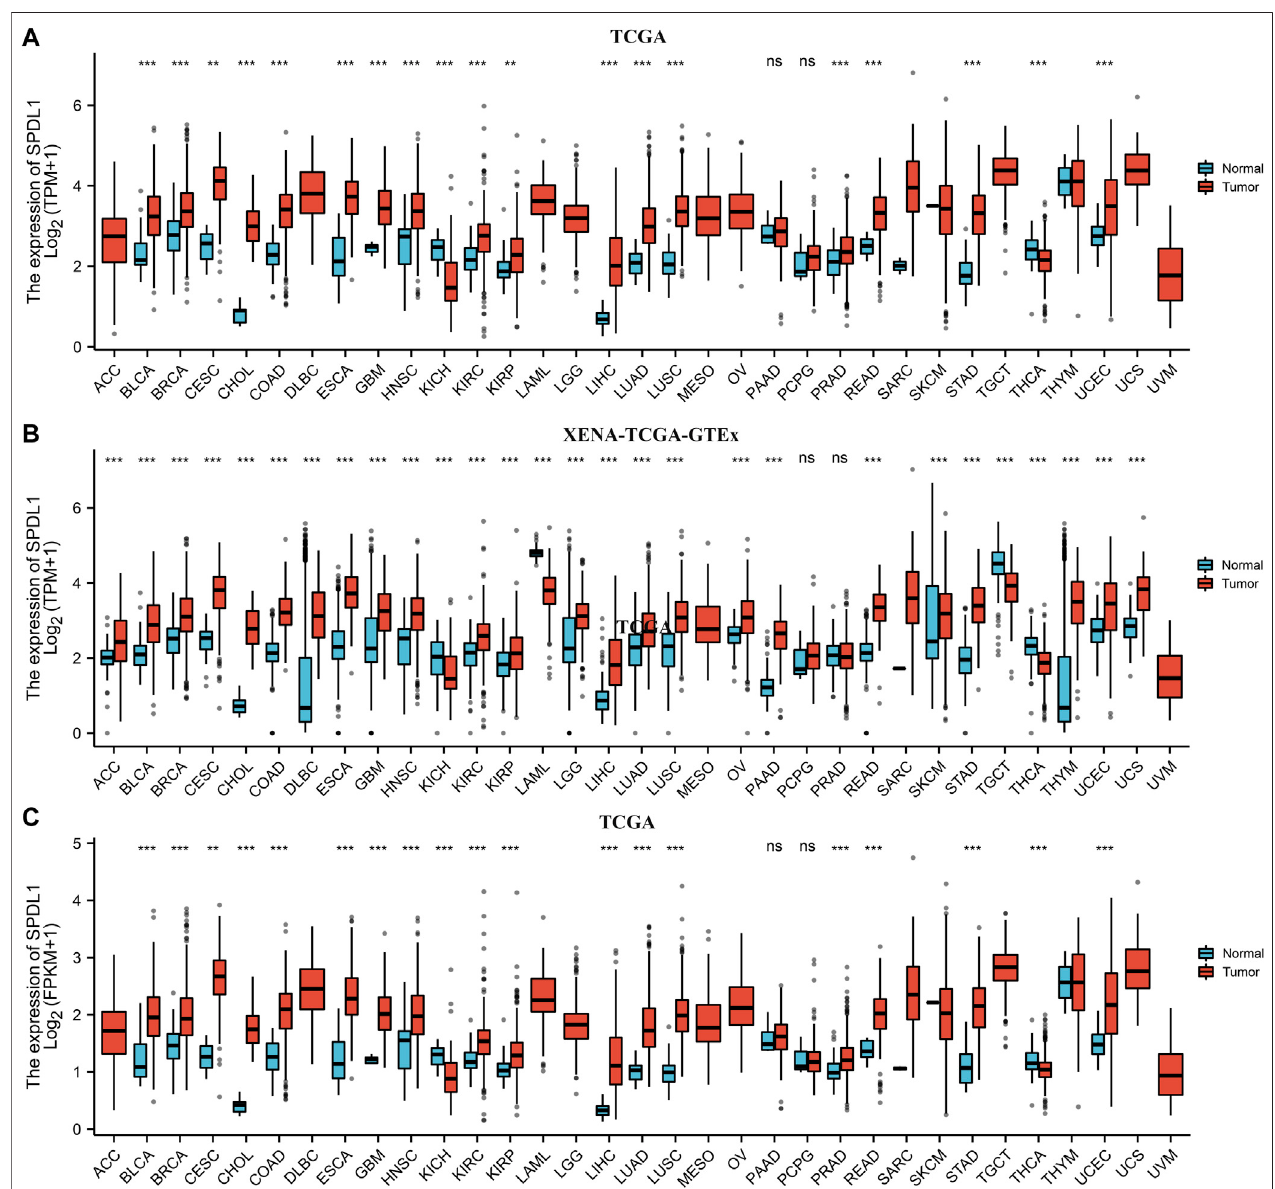
FIGURE 1 | Pan-cancer data from multiple databases showed that SPDL1 was abnormally expressed in pan-cancer tissues. (A) TPM-type data from the TCGA database. (B) TPM-type datafrom theTCGA +GTEx databases. (C) FPKM-type datafrom theTCGA database.SPDL1, spindle apparatuscoiled-coil protein 1; TCGA, The Cancer Genome Atlas; GTEx, Genotype-Tissue Expression; TPM, transcripts per million; FPKM, fragments per kilobase per million; NS, not signi fi cant; *, p < 0.05; **, p < 0.01; ***, p < 0.001.